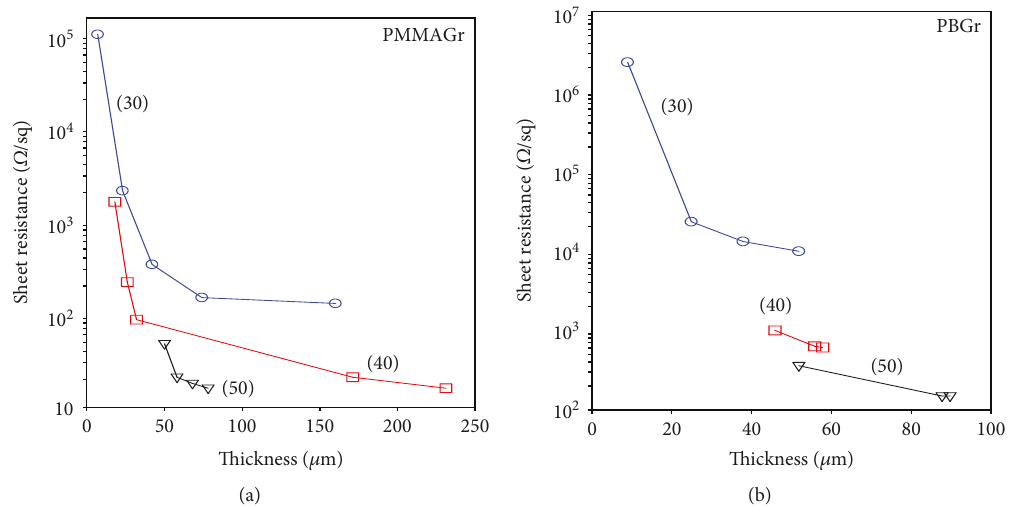
Figure 4: Sheet resistance of heating fi lms. (a) PMMAGr and (b) PBGr. The numbers enclosed in parentheses represent the amounts of graphite added to the composite fi lms.